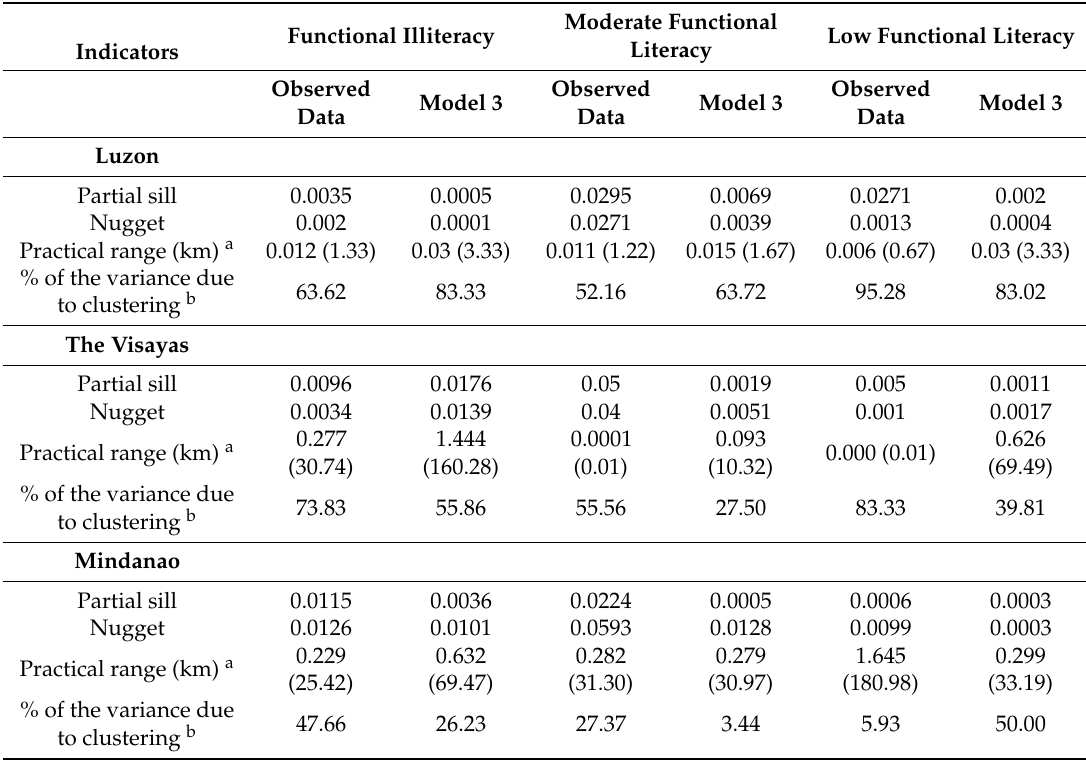
Table 6. Results of semivariograms for prevalence of functional illiteracy and moderate and low functional